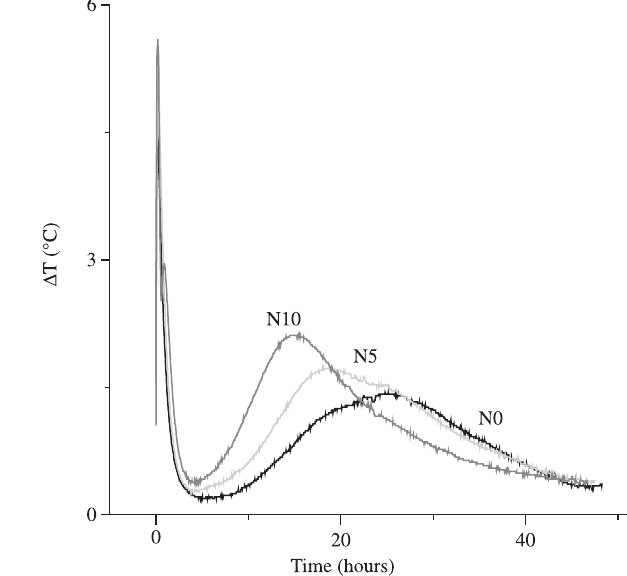
Figure 3. Calorimetric curves, first 48 hours of hydration.